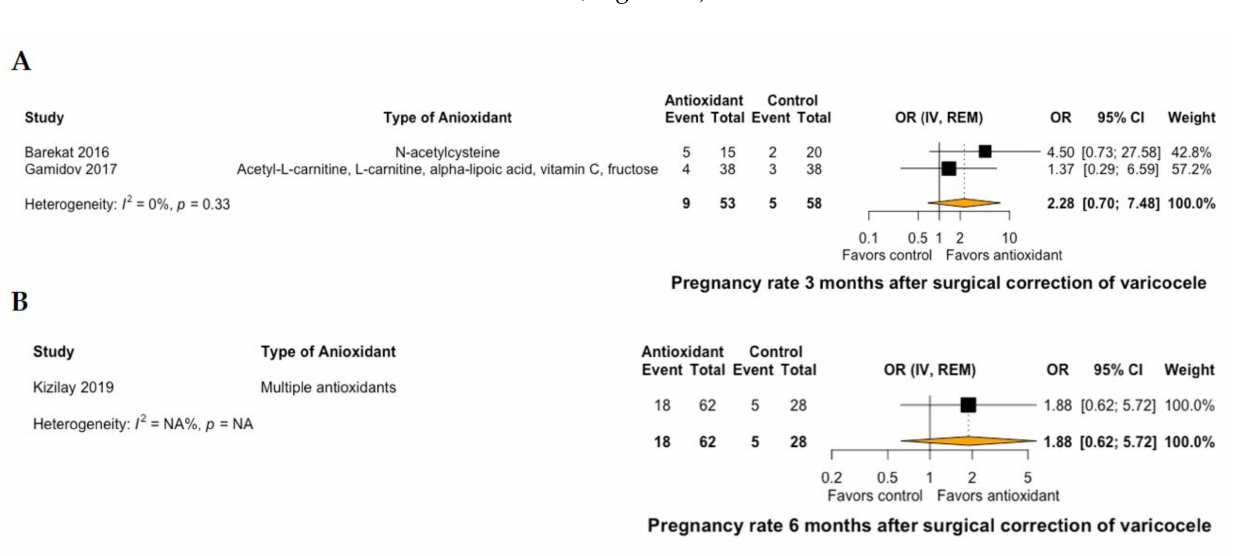
Figure 2. Forest plot of pregnancy rate at 3 months ( A ) and 6 months ( B ) of patients with surgical correction of varicocele and treatment with antioxidants versus no treatment. CI: confidence interval; IV: inverse variance; OR: odds ratio; REM: random effects